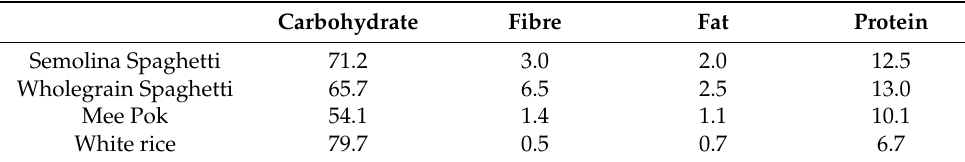
Table 1. Macronutrient composition per 100 g.